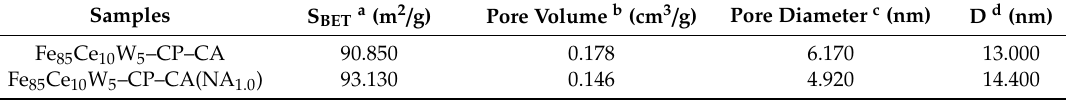
Figure 5. N 2 adsorption and desorption isotherms ( A ), pore diameter distributions ( B ), and desorption cumulative pore volume ( C ) of catalysts. Table 2. The surface area, pore volume, diameter, and average crystallite size of the catalysts.